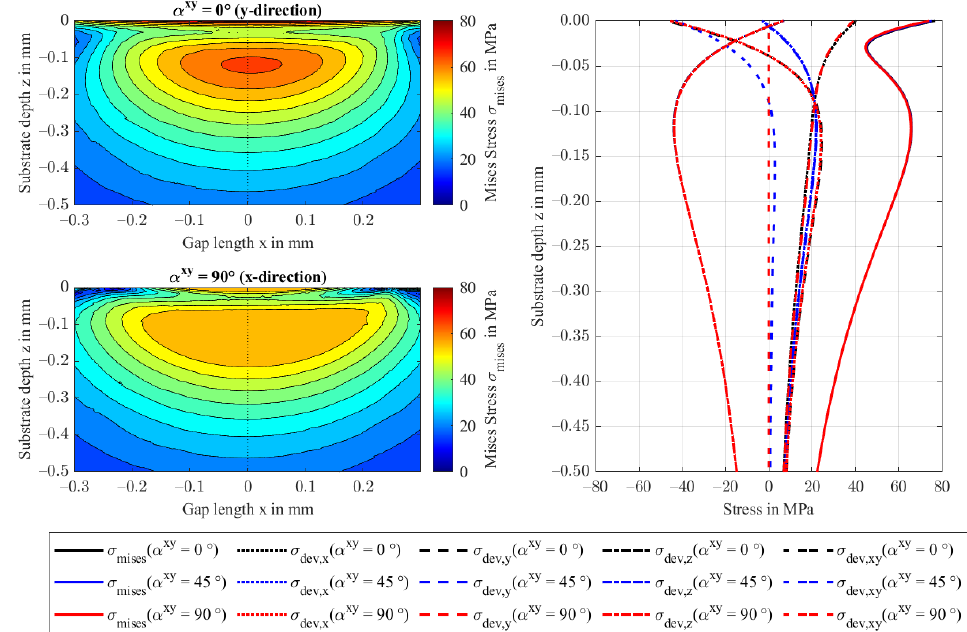
Figure 13. von Mises stresses in the xz-plane at y = 0 for 𝛼 𝑥𝑦 = 0 and 90° ( left ) and the respective deviatoric stresses at the contact center of the FRP in substrate depth direction z ( right ).